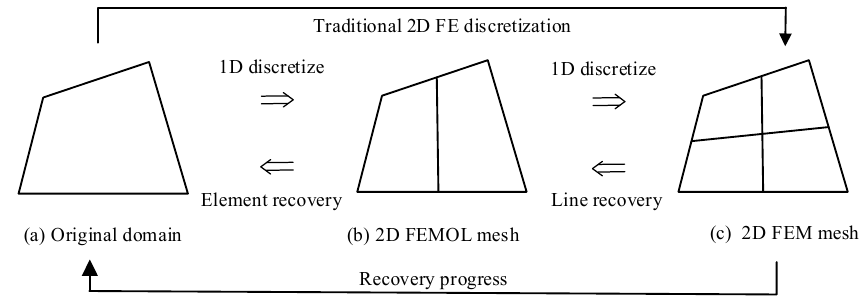
Figure 1. Global D-by-D discretization and recovery of 2D problems.